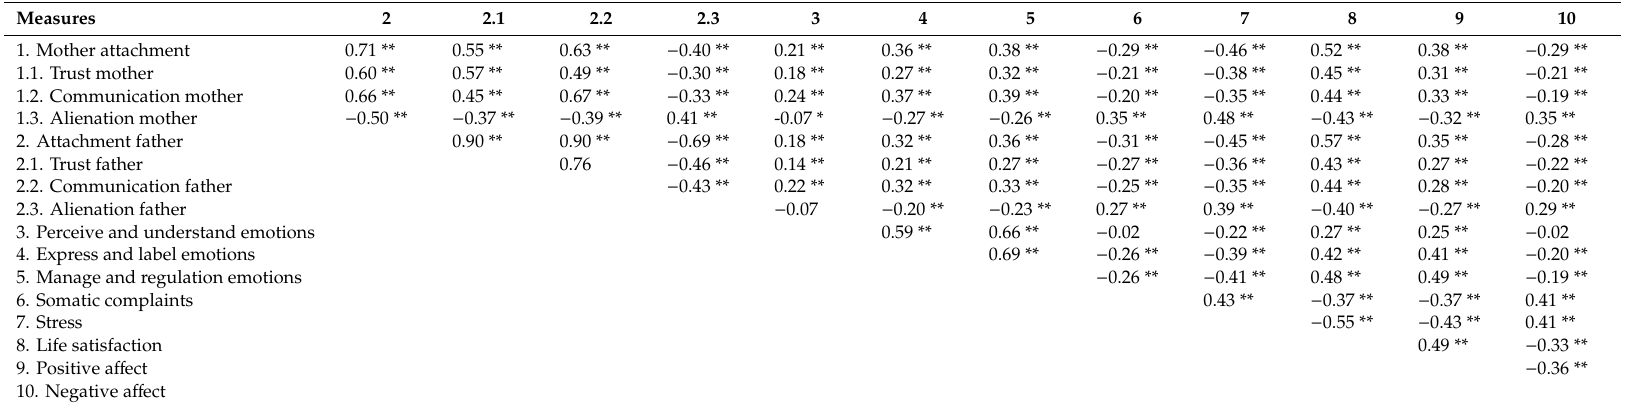
Table 2. Intercorrelations among variables